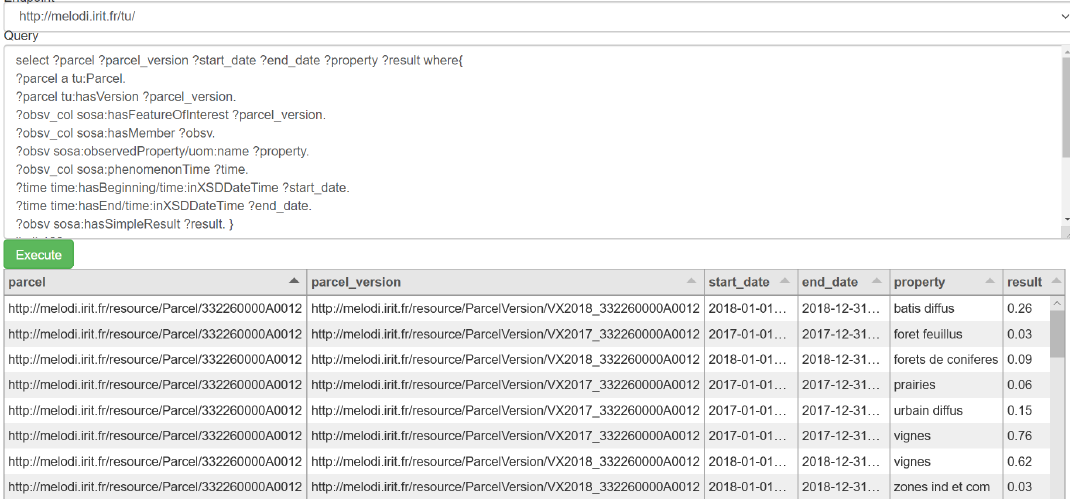
Figure 5. Monitoring land cover